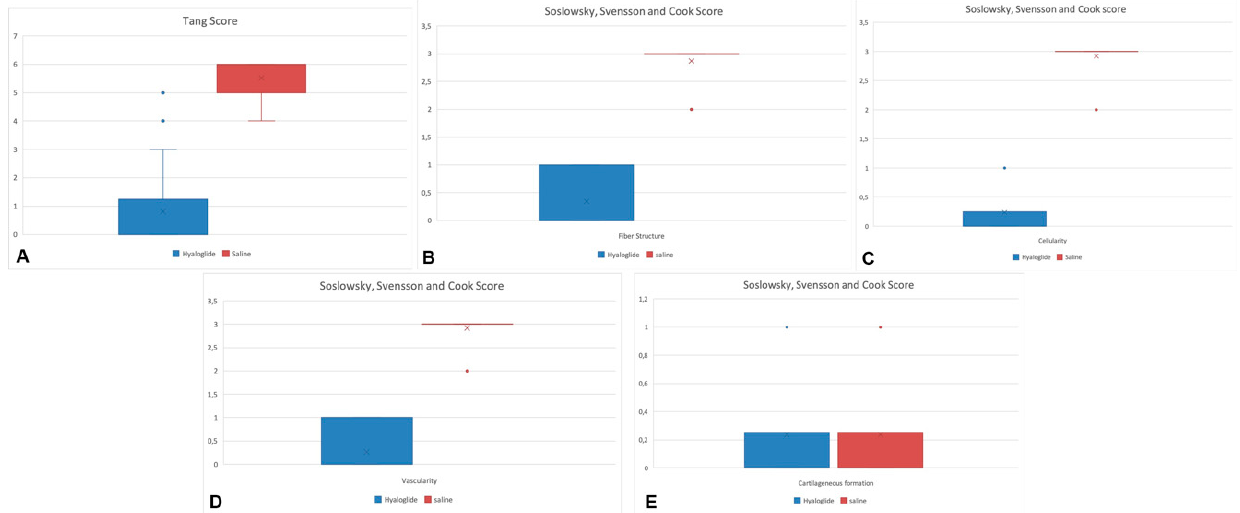
Figure 4. The positive outcomes of the Hyaloglide group were highlighted via comparative statistical analysis of the adhesion evaluation score (Tang score: total adhesions OR = 0.01, p < 0.05) ( A ) and tendon regeneration (Soslowsky, Svensson, and Cook score: fiber structure OR = 0.08, p < 0.05 ( B ); cellularity OR = 0.03, p < 0.05 ( C ); vascularity OR = 0.03, p < 0.05 ( D ); cartilaginous formation OR = 0.10, p > 0.05 ( E )) specifically reporting decreased adhesion formation and an improved regeneration. Table 3. Tang score and Soslowsky, Svesson, and Cook score results of tendons treated or not with Hyaloglide.